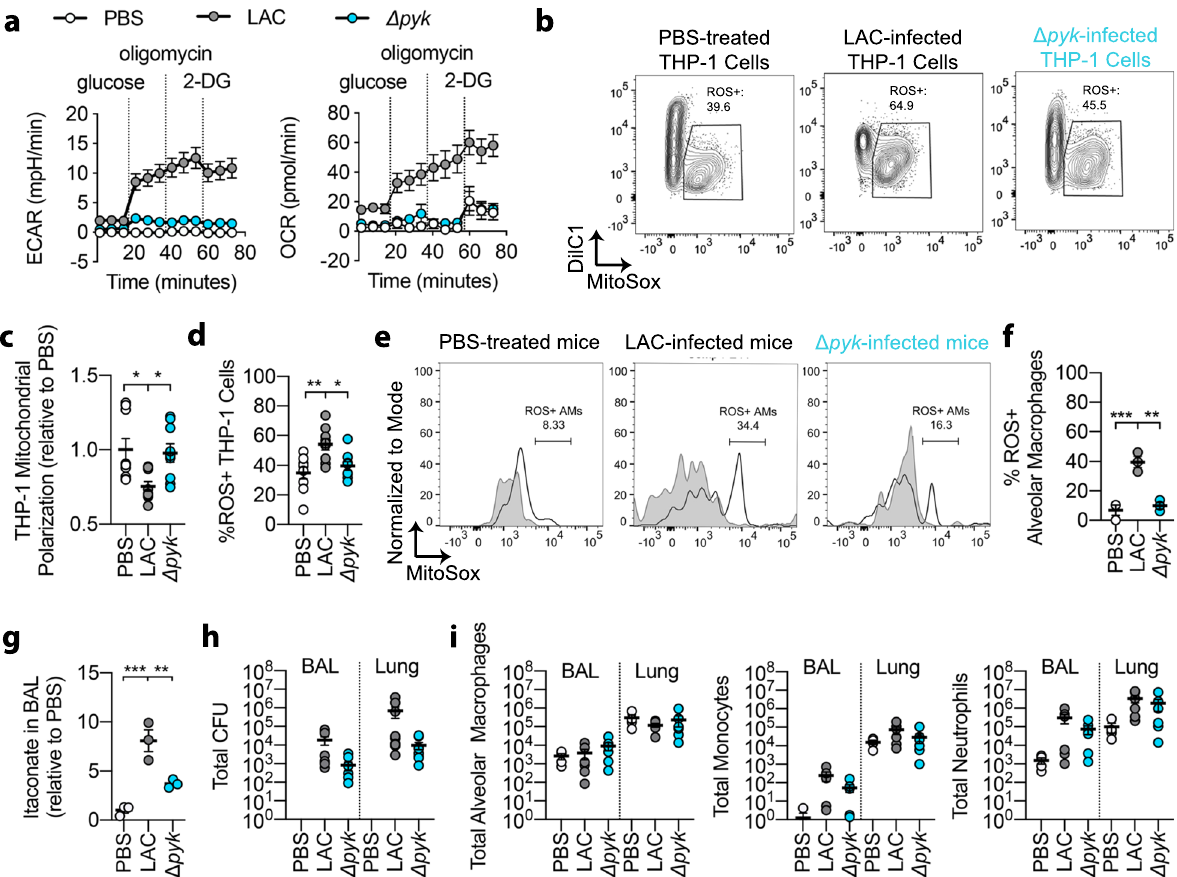
Fig. 2 S. aureus glycolytic activity induces host mitochondrial ROS and itaconate production. a Extracellular acidi fi cation rate (ECAR; left panel) and oxygen consumption rate (OCR; right panel) of LAC S. aureus or a glycolytically inactive ( Δ pyk ) mutant . b , c Mitochondrial membrane polarization and b , d ROS generation in THP-1 cells treated with PBS or infected with LAC or Δ pyk . e , f Mitochondrial ROS generation in the alveolar macrophages of mice treated with PBS or infected with LAC or Δ pyk . g Itaconate in the BAL fl uid of mice treated with PBS or infected with LAC or Δ pyk . h Total colony forming units (CFU) and i . immune cells in the BAL fl uid and lung tissue of mice treated with PBS or infected with LAC or Δ pyk . Data are shown as mean ± SEM from n = 3 biological replicates from 3 independent experiments ( a ), 9 biological replicates from 3 independent experiments ( b , c , d ), 3 mice ( e , f , g ), or 6 mice ( h , i ). Signi fi cance determined by One-Way ANOVA with Tukey ’ s Multiple Comparisons ( c , d , f , g , h , i ); * P < 0.05; ** P < 0.01; *** P <